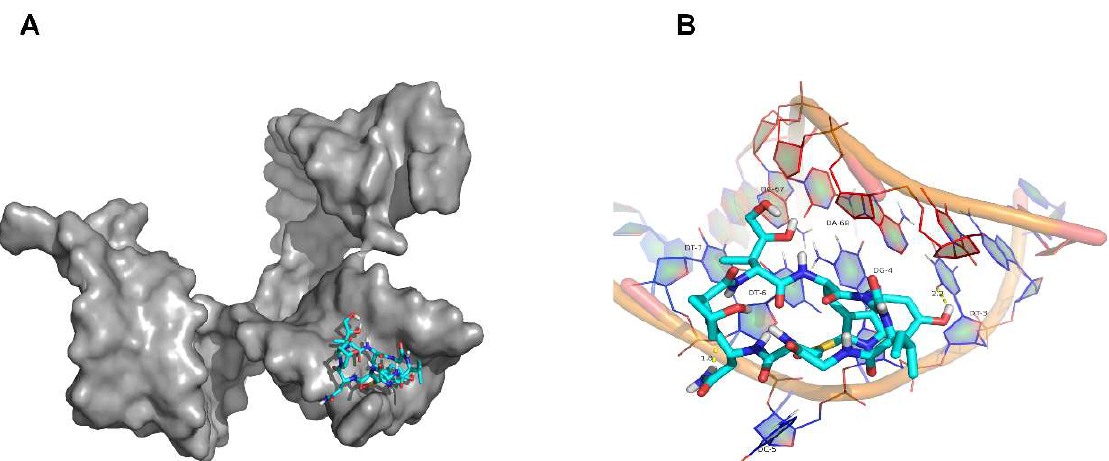
Figure 3. haracterization of the α-amanitin aptamer and truncated aptamer. ( A ) Determining α-am- anitin aptamer and truncated aptamer affinity. The aptamer concentrations (0, 50, 100, 200, 400, 800, and 1600 nM) were combined with equal amounts of α-amanitin (1 μg/mL), and the Kd values were analyzed by non-linear regression analysis using GraphPad Prism 8 software. ( B ) Specific test of aptamers with α-amanitin and other non-targets (β-amanitin, DON, AFB1, FB1, OTA). ( C ) Blank control: ITC results for titration of α-amanitin with ultrapure water. ( D – I ) ITC results of aptamer titration of α-amanitin.